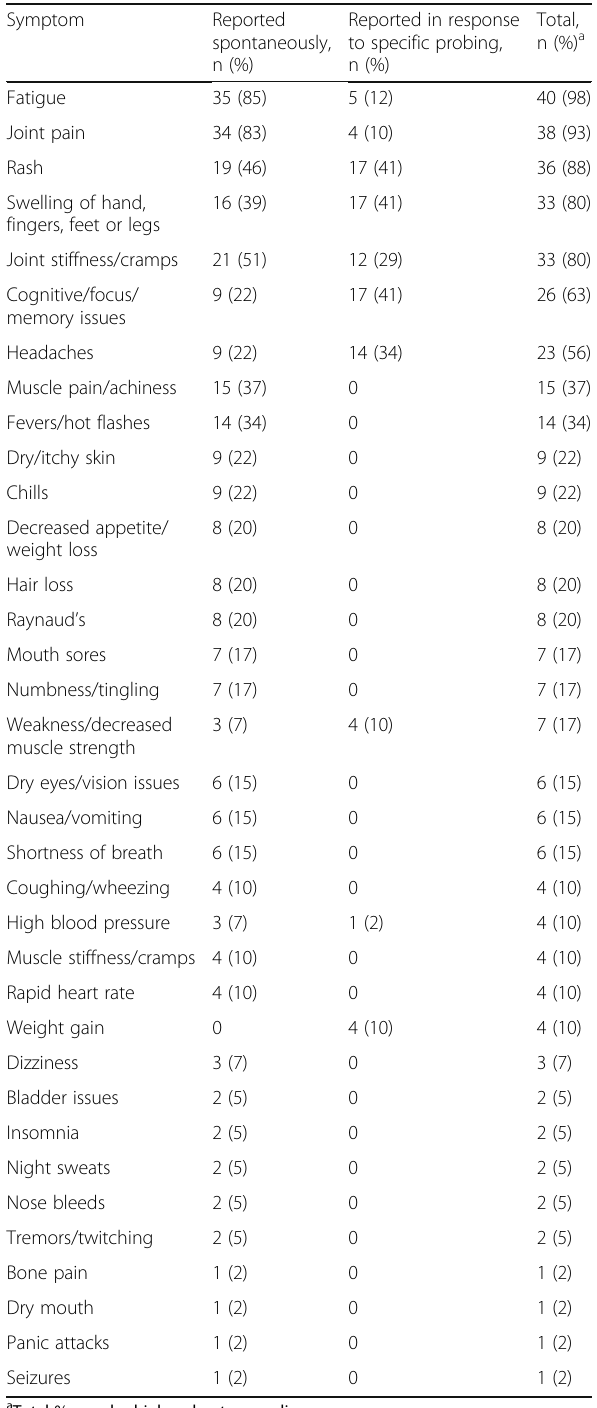
Table 3 Frequency of symptoms reported during CE interviews (n = 41) when patients were asked to describe what symptoms they experience as a result of